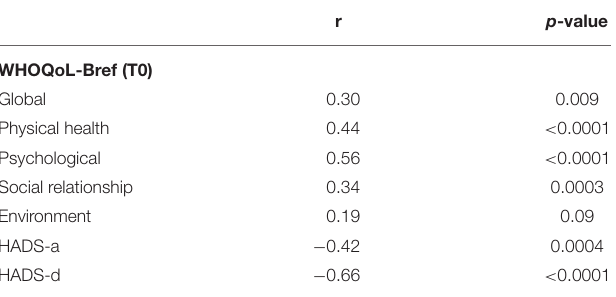
TABLE 3 | Correlation between RS-14 and the other psychological